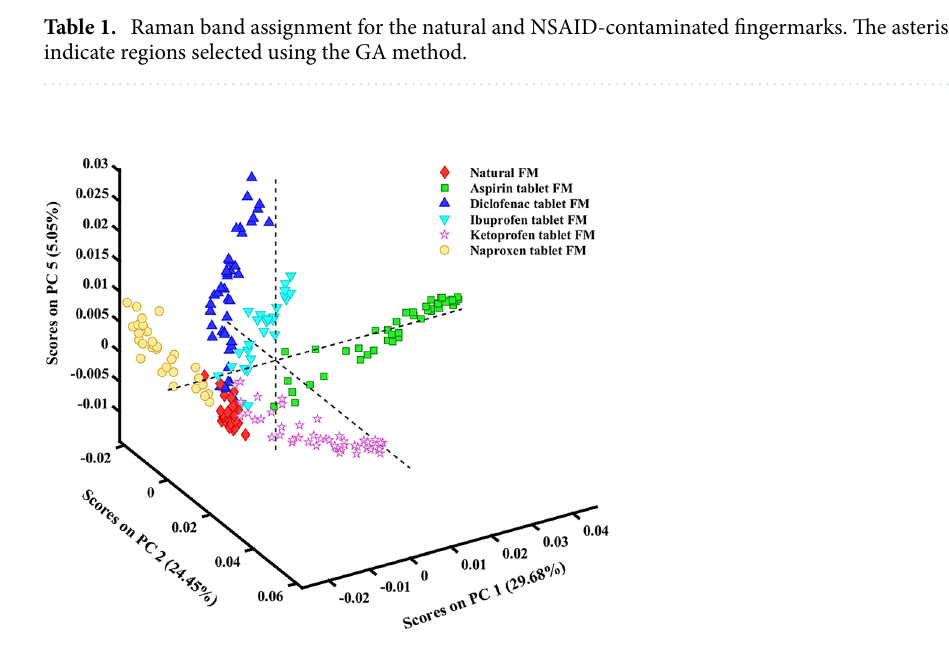
Figure 2. PCA scatter plot for individual Raman spectra of natural and NSAID-contaminated